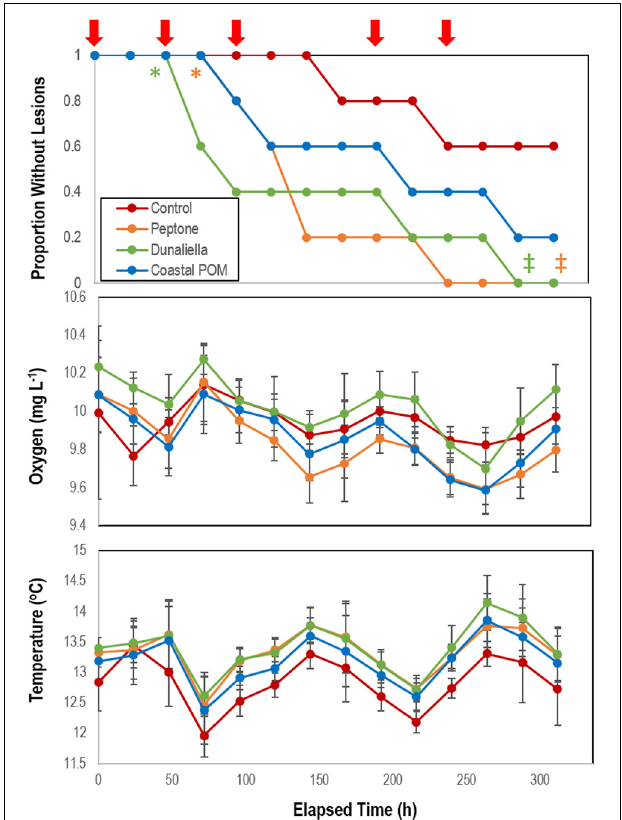
FIGURE 2 | Proportion of grossly normal P. ochraceus ( n = 5 each treatment) incubated in flow-through conditions at the Bodega Marine Lab in response to organic matter enrichments (Peptone, Dunaliella tertiolecta culture POM, and coastal POM collected from the inflow at the Bodega Marine Laboratory in August 2019). Dissolved O 2 and temperature were measured in flow-through sea tables bearing each OM treatment. Error Bars = SE. The red arrows above the top panel indicate sampling for microbiome analyses. * indicates wasting speed (i.e., time to appearance of first lesion) was significantly ( p <